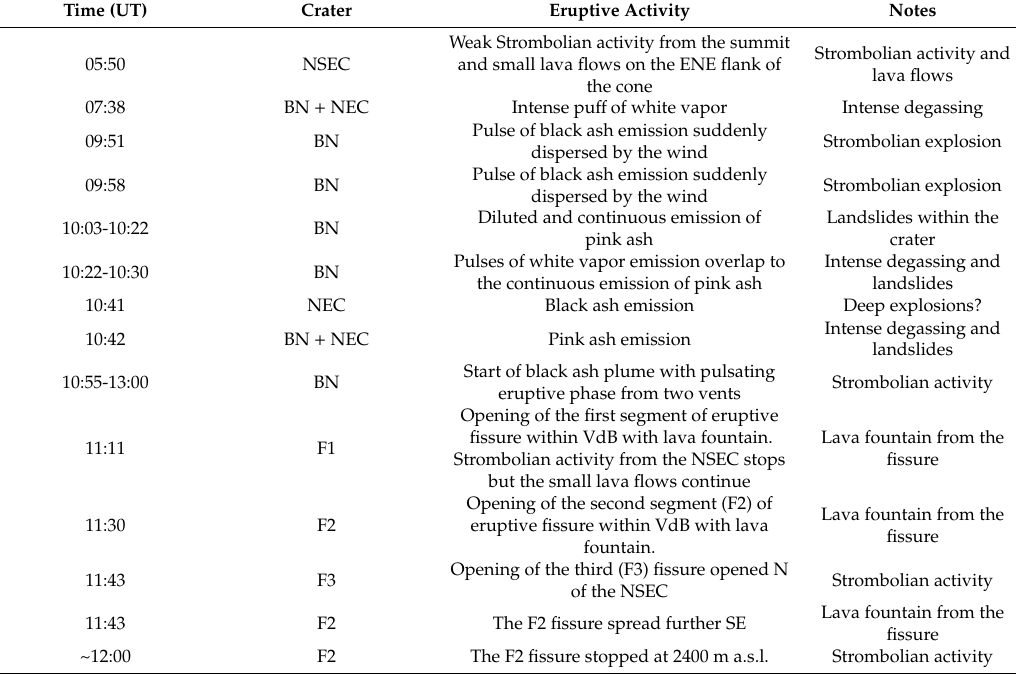
Table 2. Sequence of the main eruptive events detected by the INGV-OE cameras monitoring network on 24 December 2018. NSEC = New SE Crater; BN = Bocca Nuova; NEC = NE Crater; FER = Eruptive Fissure; VdB = Valle del Bove